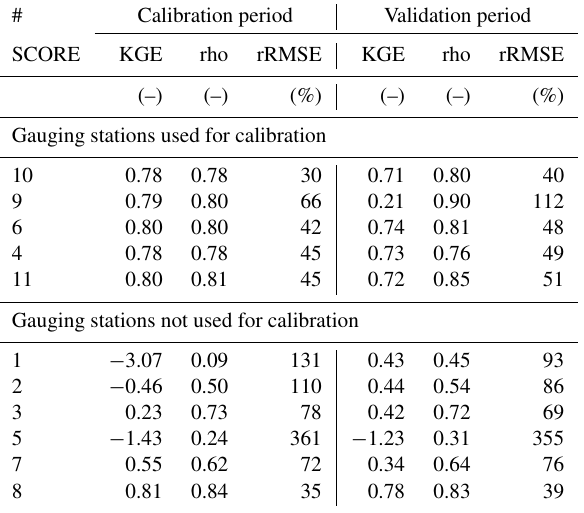
Table 2. Performance scores obtained over the Mississippi River gauging stations during the calibration and validation